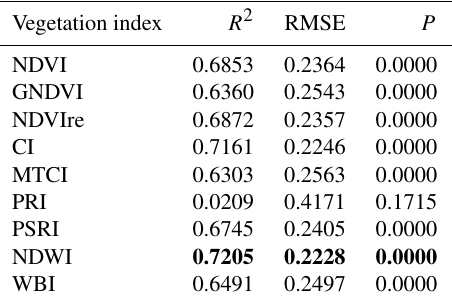
Table 4. Linear regressions established between lnGPP and vegeta- tion indices (VI) selected for this study (see Table 2). Best regres- sion is shown in